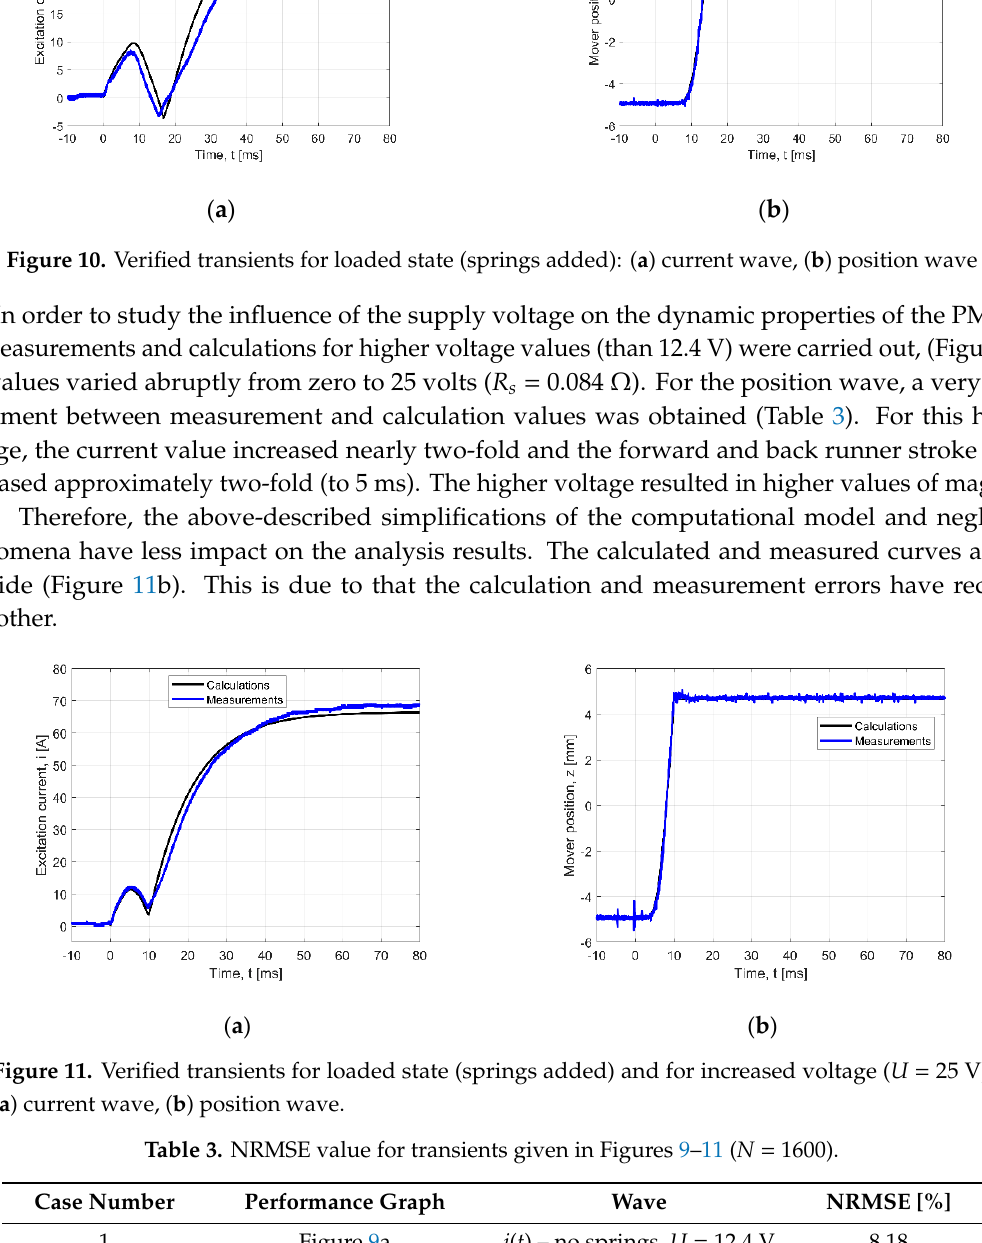
Figure 9. Verified transients for no-load state: ( a ) current wave, ( b ) position wave.